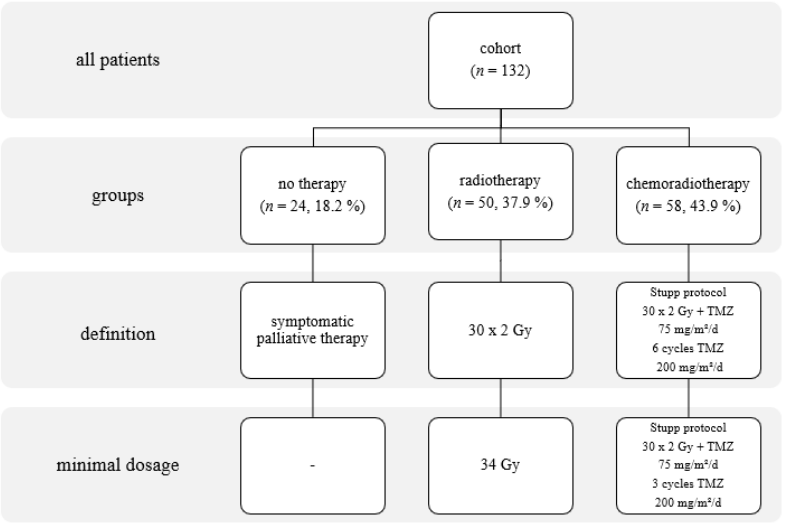
Figure 1. Stratification of the cohort based on treatment modality, with details of the applied treat- ments. Tumor tissue samples were collected in both formalin-fixed paraffin-embedded (FFPE) and fresh-frozen form. Clinical and MRI follow-up information was gathered at regular three-monthly intervals. Smoking status was obtained from the clinic’s preopera- tive questionnaire. Patients were classified as non-smokers (83/132 = 62.9%) if they had never smoked or had quit smoking at least five years before diagnosis; the remaining pa- tients (49/132 = 37.1%) were classified as smokers. All of the tumors were classified ac- cording to the latest WHO classification of CNS tumors by two local neuropathologists. Immunohistochemical analysis of IDH1 R132H and Ki67 status was included in the stand- ard classification procedure. All patients signed informed consent forms. 2.2. Immunohistochemical Determination of IDH1 R132H Status The study cohort consisted of GBM patients with IDH wildtype status according to the WHO 2016 diagnostic criteria. The 1 – 2 μm thick tissue sections were pre-treated using the PT Link system (Agilent, Santa Clara, CA, USA) at 97 °C, pH 9 for 20 min to ensure epitope retrieval. Hydrogen peroxide was used to block endogenous peroxidase activity. The sections were subsequently treated with the primary antibody, Anti-IDH1R132H clone H09 (Dianova, Hamburg, Germany), at a dilution of 1:100 for 20 min at room tem- perature. EnVision Flex+, Mouse, High pH (Agilent DAKO) was used to amplify the pri- mary antibody signal. The sections were then treated for 20 min with the secondary anti- body, EnVision Flex/HRP (Agilent DAKO), after which the reaction was visualized using the DAB+ Substrate Chromogen System (Agilent DAKO). 2.3. Immunohistochemical Determination of Ki67 Status The 1 – 2 μm thick tissue sections were microw aved in citrate buffer (pH 6) for 10 min at 120 °C to ensure antigen retrieval. Hydrogen peroxide was used to block endogenous peroxidase activity (Mouse/Rabbit ImmunoDetector DAB HRP Brown System, Bio SB, Santa Clara, CA, USA). The sections were subsequently treated for 30 min with the pri- mary antibody, Ki67 antigen, MIB-1 (Agilent DAKO), at a dilution of 1:200. After treat- ment with the secondary antibody (Mouse/Rabbit ImmunoDetector DAB HRP Brown Sys- tem, Bio SB) for 30 min, the reaction was visualized using DAB+ Substrate Chromogen.